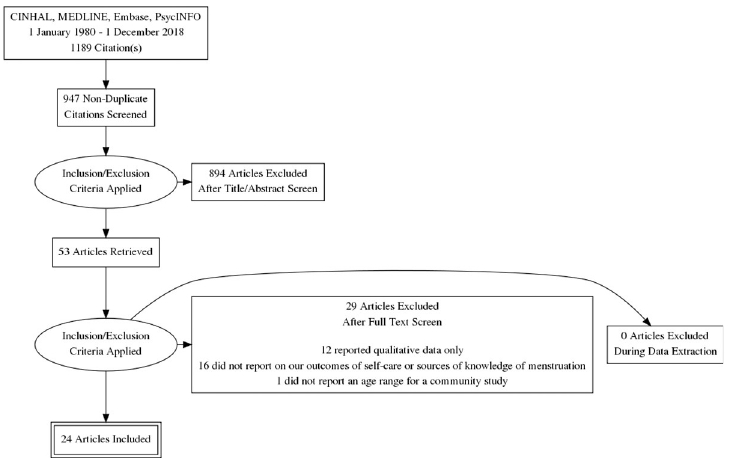
Fig 1. PRISMA flow diagram of the search and selection